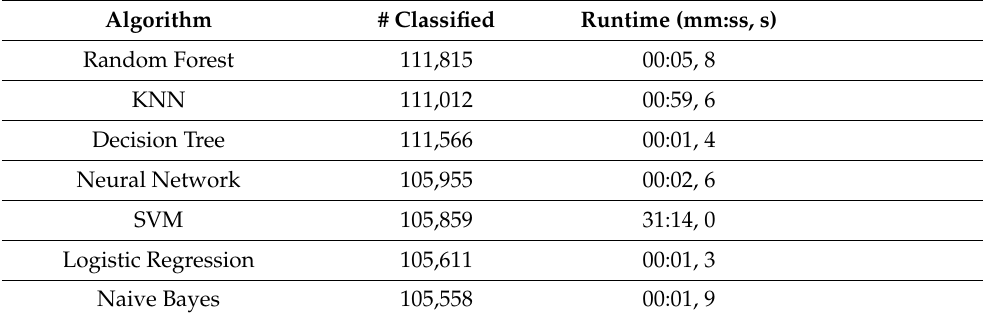
Table 5. Raspberry PI final runtime and quantity.